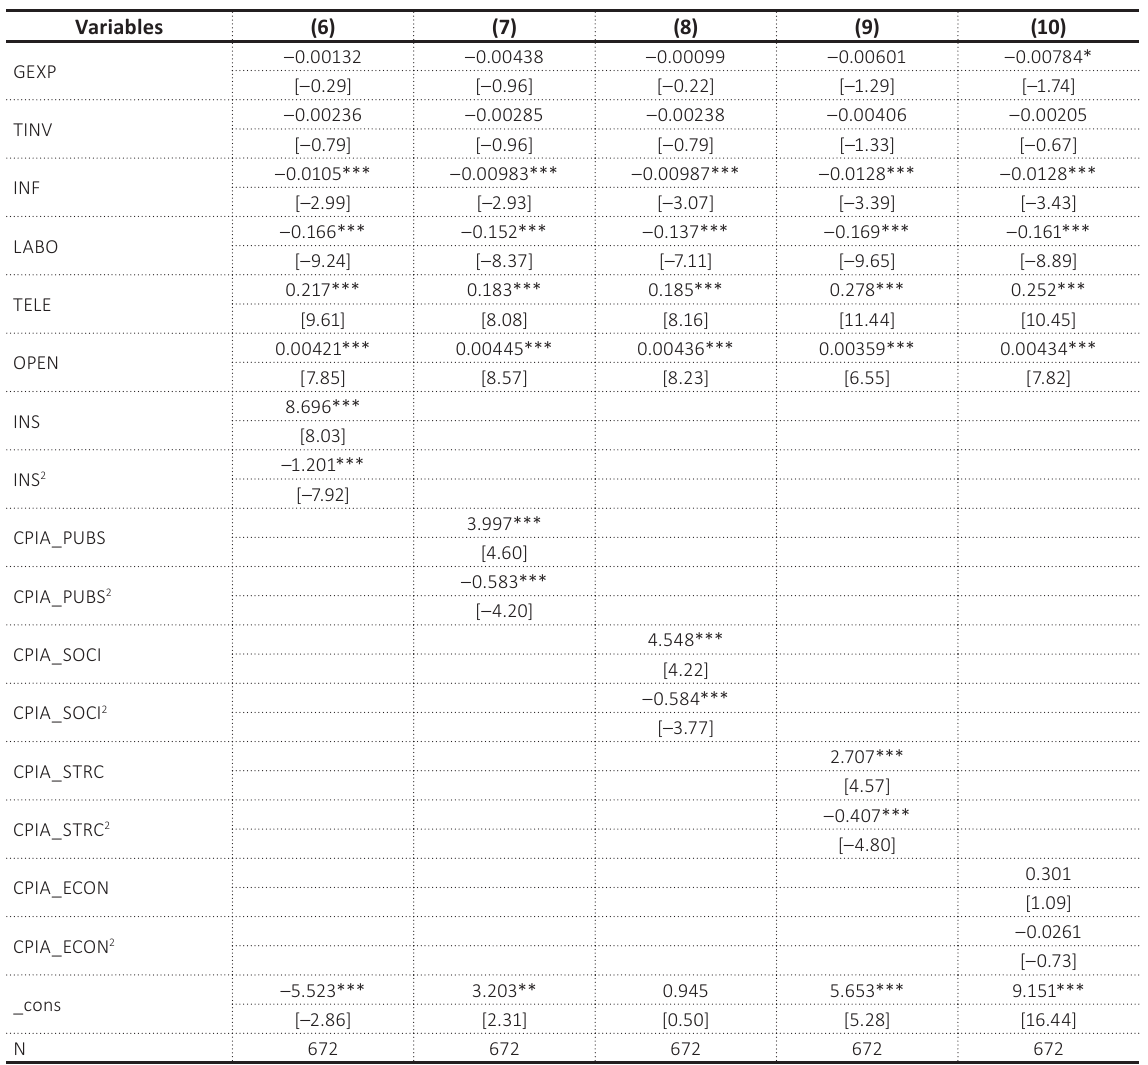
Table 3. Results of FGLS method for models (6), (7), (8), (9) and